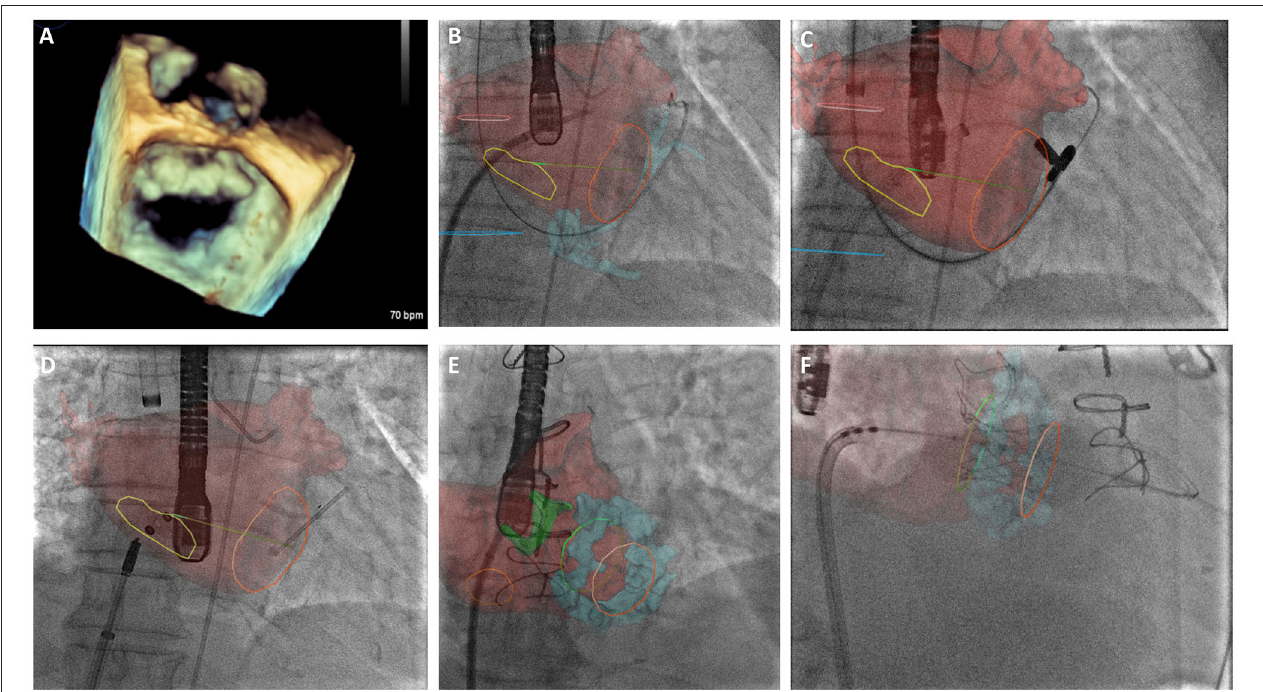
FIGURE 2 | (A) 3-Dimensional transesophageal echocardiographic (TEE) real-time reconstruction of the mitral valve annulus and leaflets as a preliminary investigation to determine anatomical suitability for transcatheter mitral intervention. (B) CT overlay with real-time image fusion to demonstrate the optimal site for trans-septal puncture for ARTO case. Yellow line delineates inter-atrial septum, left atrium is superimposed in red. (C) CT overlay with real-time image fusion during magnet positioning during ARTO case (D) real-time image fusion demonstrating T-bar and atrial septal defect (ASD) occluder device device positioning relative to mitral annulus (orange circle) and inter-atrial septal markers (yellow circle), respectively. (E) CT overlay with real-time image fusion during transeptal puncture for transcatheter mitral valve implantation in mitral annular calcification identifying interatrial septum (orange circle), atrial anatomy (red) and mitral annular calcification (blue), aortic bioprothesis is also delineated (green). (F) CT overlay with real-time image fusion to facilitate transcatheter mitral valve in MAC positioning, atrial anatomy (red) and mitral annular calcification (blue) are visualized in addition to the superior (green) and inferior markers